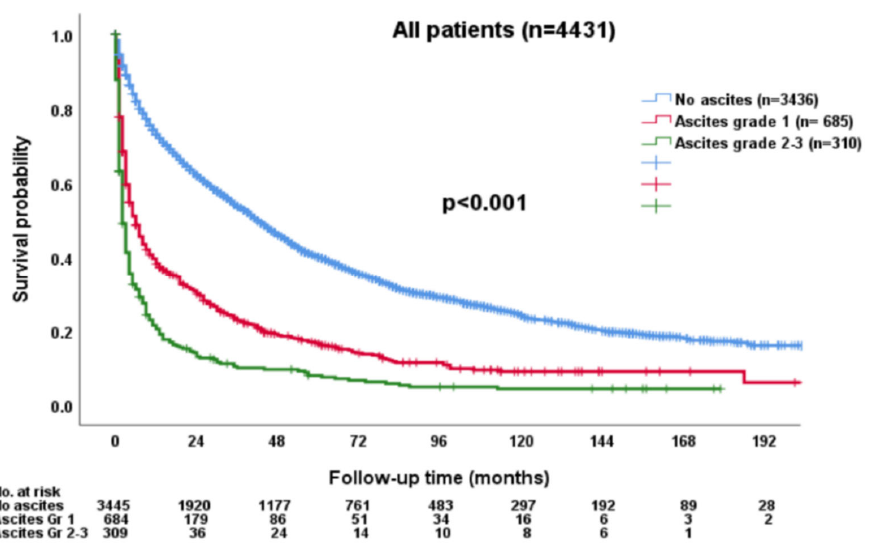
Figure 2. The survival distribution according to the grade of ascites. Patients with higher grades of ascites had worse overall survival compared with patients without ascites or with lower grade ascites ( p < 0.001).